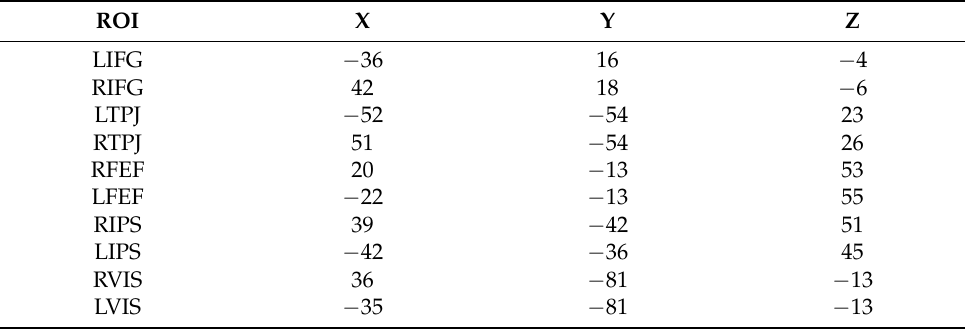
Table 1. Coordinates of selected ROIs. R and L define right and left brain